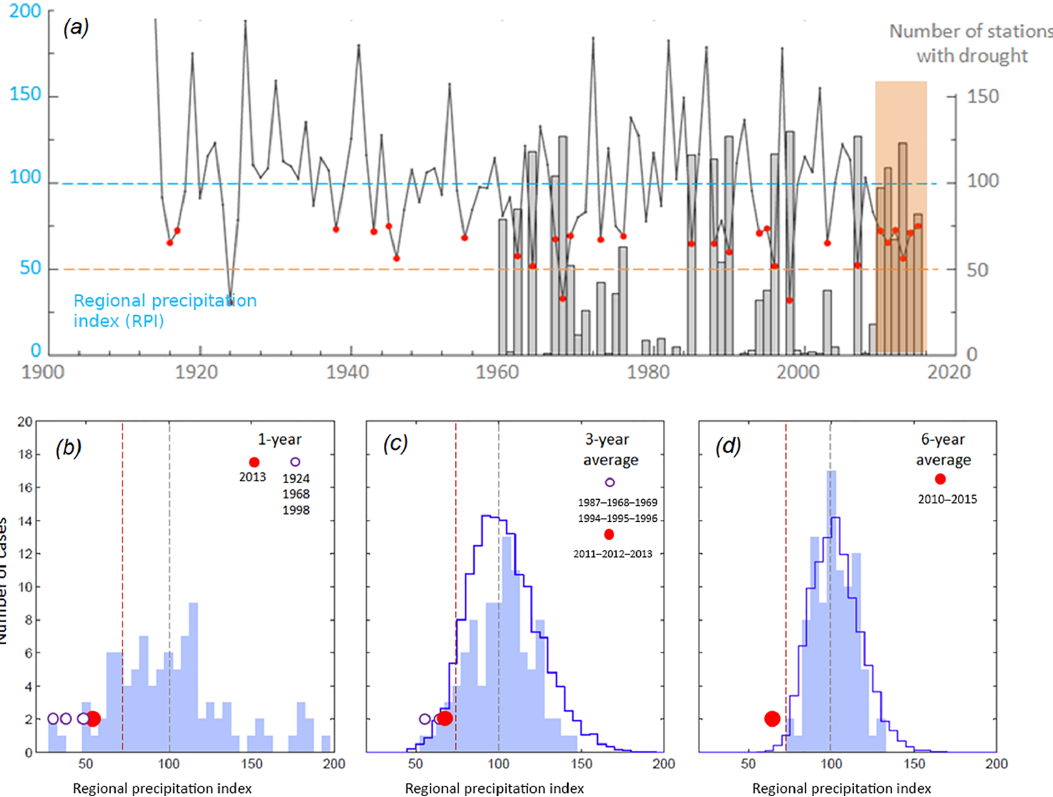
Figure 3. (a) Time series of the annual regional precipitation index (RPI, black line; red circles indicate drought years) and number of stations (bars, scale at right) in drought (SPI12-D< − 1.1). The total number of stations in the core of central Chile (32.5–36.5 ◦ S) is 153. The orange area indicates the MD period. (b) Histograms of the historical RPI values (light blue bars; 1915–2009). The red circle indicates the worst year during the MD; the smaller purple circles indicate the values in contemporaneous droughts. (c) and (d) : as (b) but for 3-year and 6-year averages, respectively. The blue thick line is the distribution obtained from 5000 3-year periods formed by randomly selecting 3 or 6 years in the historical